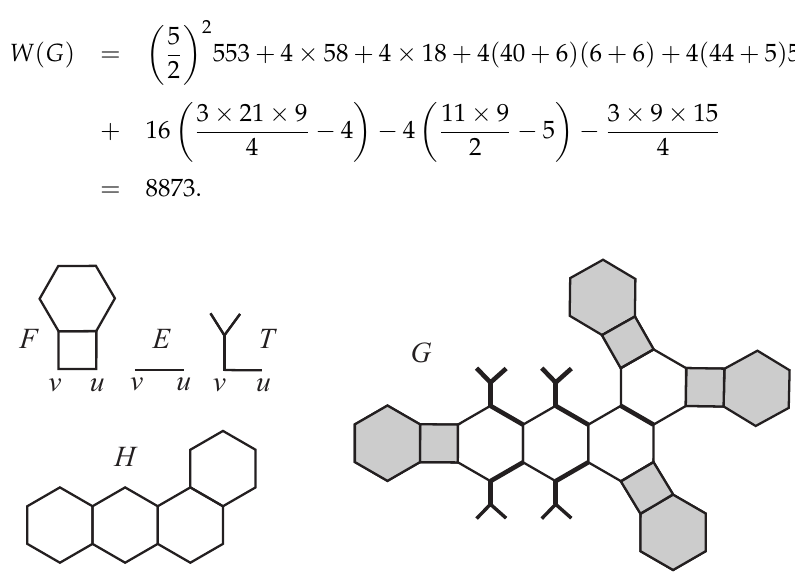
Figure 7. Benzenoid graph H and its edge thorny graph G .